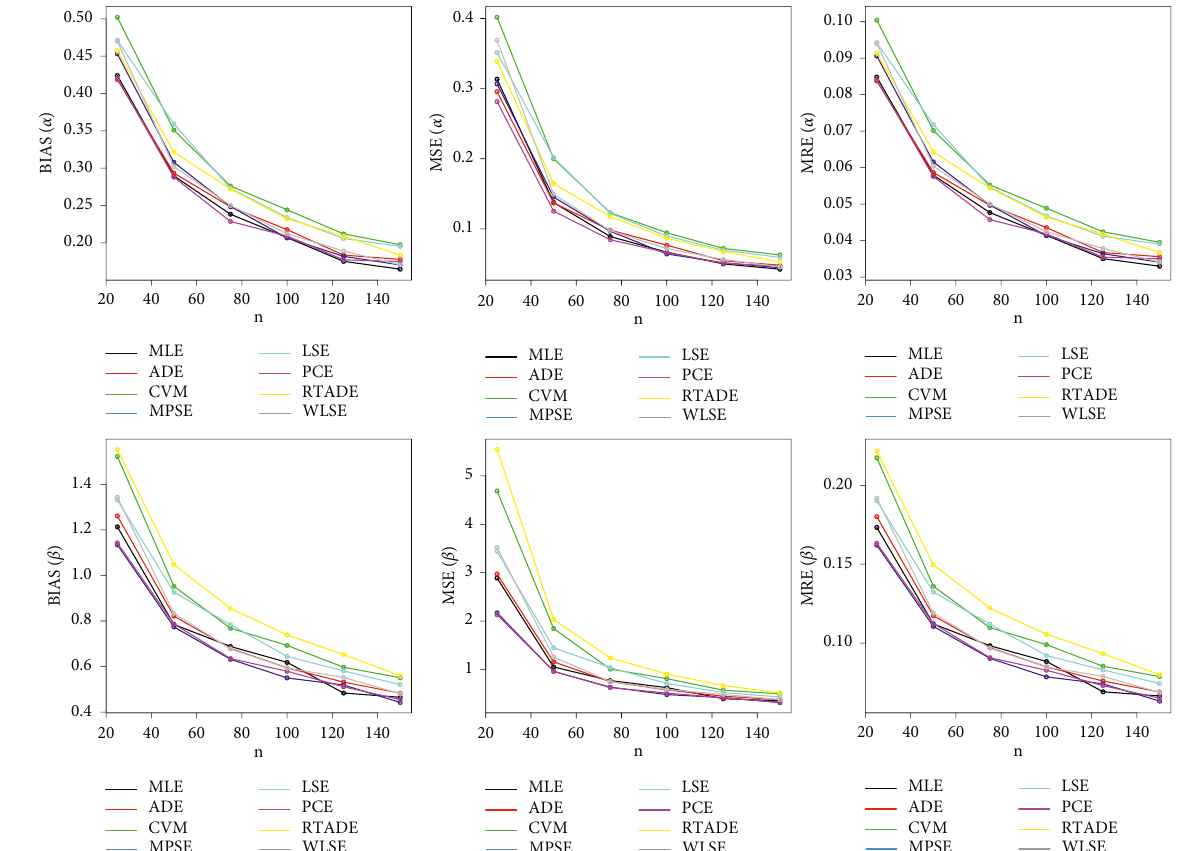
Figure 7: Graphical representation of BIAS, MSE, and MRE values in Table